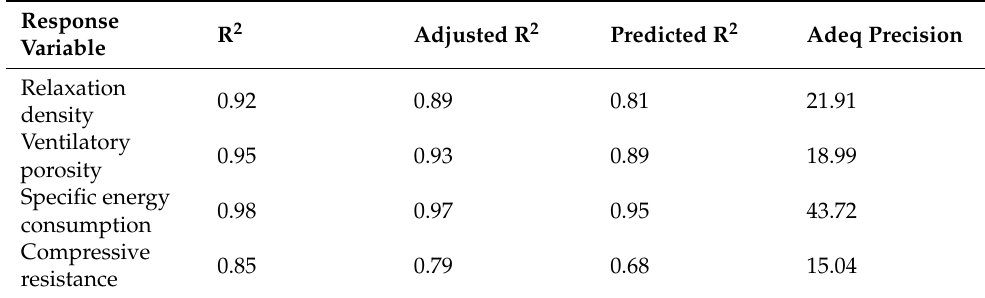
Table 4. Model fit for relaxation density, ventilatory porosity, specific energy consumption, and compressive